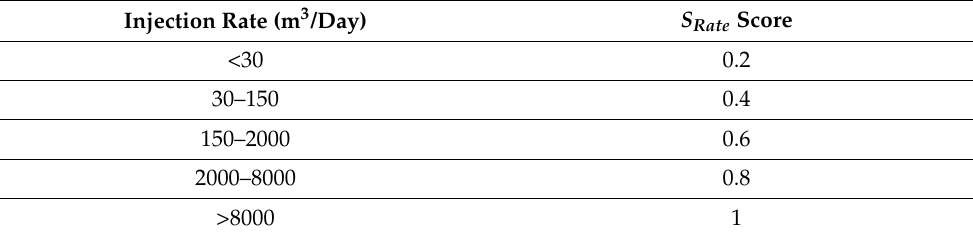
Table 5. The assessment rules of the injection rate.